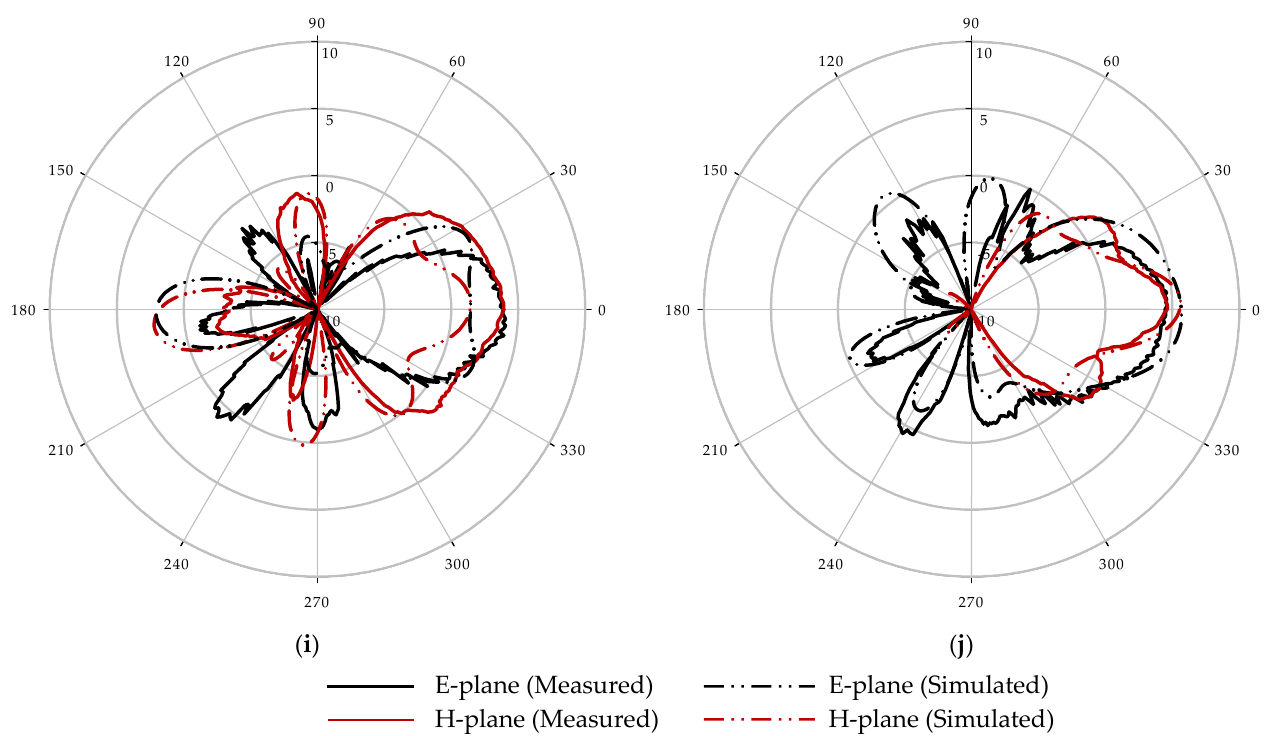
Figure 4. Measured far-field radiation pattern at E-plane and H-plane: ( a ) 5 GHz; ( b ) 6.5 GHz; ( c ) 7.5 GHz; ( d ) 8 GHz; ( e ) 9.5 GHz; ( f ) 10.5 GHz; ( g )11.5 GHz; ( h ) 12.5 GHz; ( i ) 13.5 GHz; ( j ) 14.5 GHz.